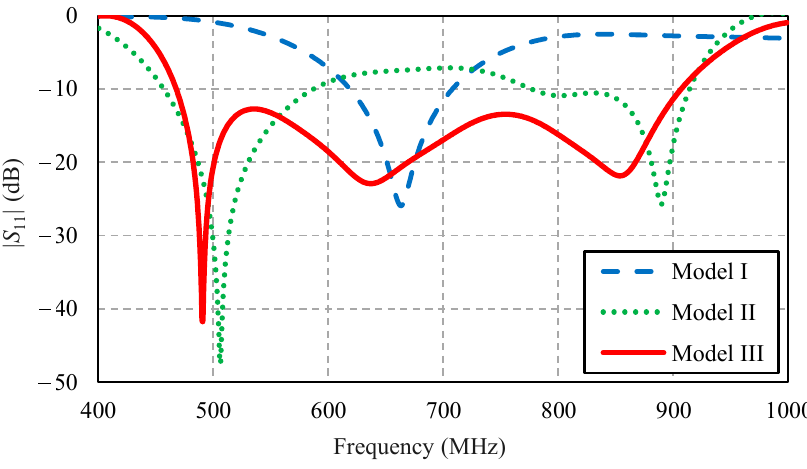
Figure 4. Simulated impedance bandwidth (| S 11 | ≤ − 10 dB) of the antenna models I, II, and III.